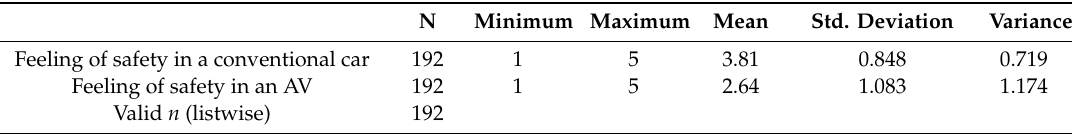
Table 11. Descriptive statistics about the feeling of safety in a conventional car /